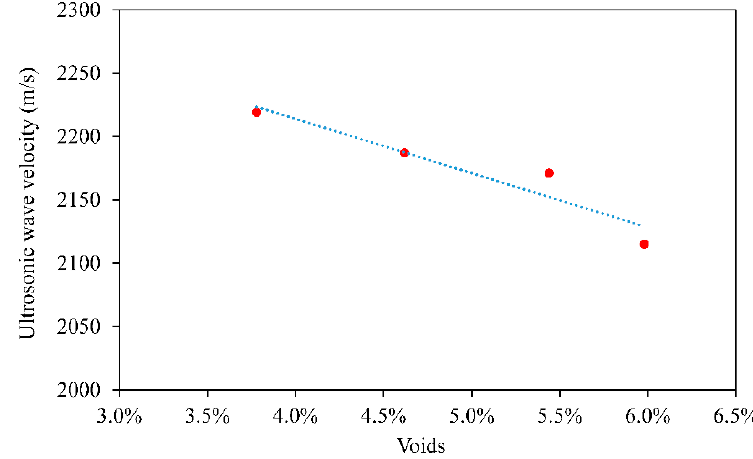
Figure 2. Relationship between ultrasonic wave velocity and voidage of the Marshall samples.